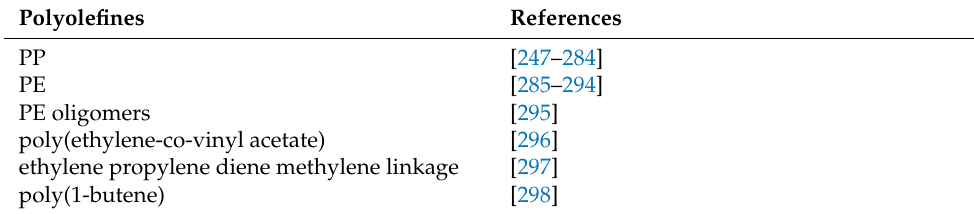
Table 4. Polyolefines classification.